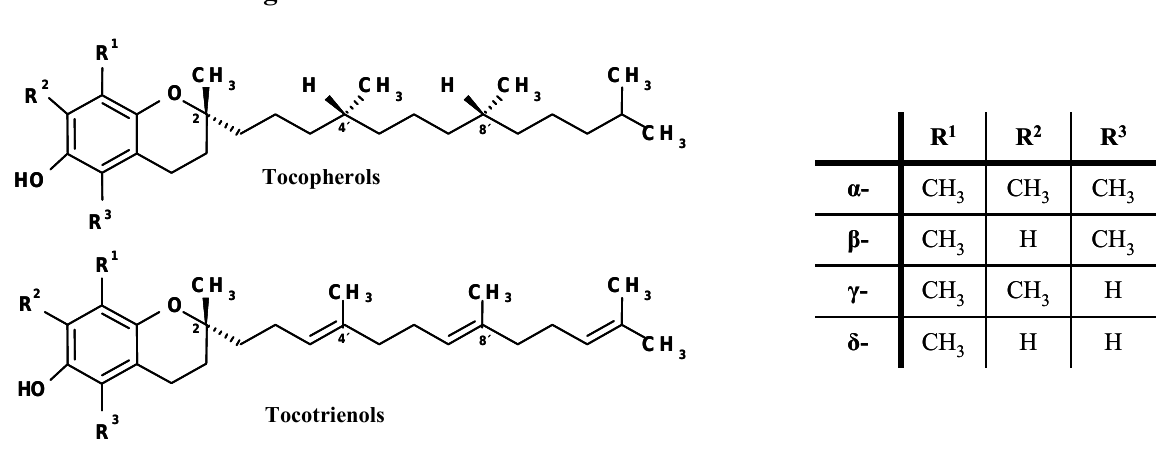
Figure 2. Molecular structure of vitamin E